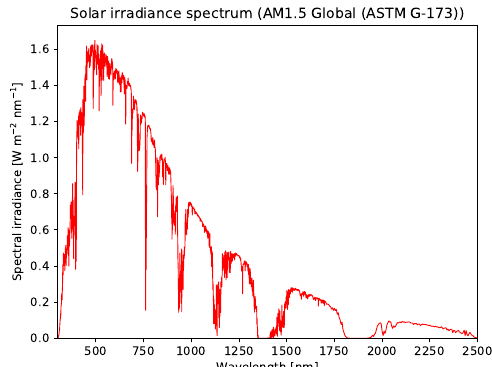
Figure 11. The solar irradiance spectrum used for the remote sensing experiments. Note that the drops to a value close to 0 in the graph, particularly at wavelengths 1350–1400 nm and 1800–1950 nm, are mostly due to absorption by water vapor.